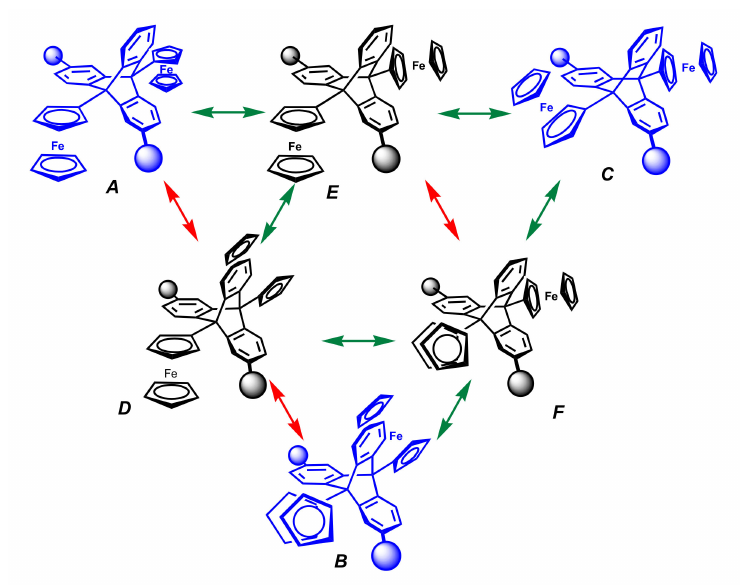
Figure 22. Possible one-step interconversion pathways between conformers of 2,6-di-tert-butyl- 9,10-diferrocenyltriptycene, 46. Green and red arrows indicate high and low barriers, respectively. Structures shown in blue are C 2 -symmetric, and those possessing only C 1 symmetry are in black